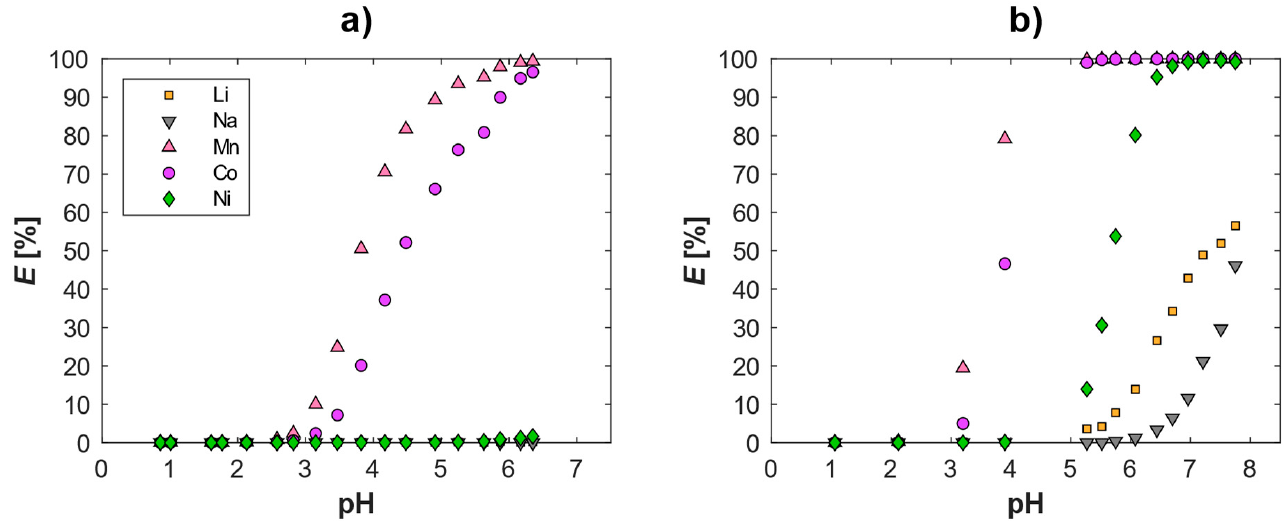
Figure 3. The effect of pH on the extraction of Li, Ni, Co, Mn, and Na by 0.8 M Cyanex 272 (diluted in Exxsol D80). T = 25 ± 1 °C; t eq = 15 min. Initial aqueous concentrations [g L − 1 ]: Li: 2.52; Ni: 2.05; Co: